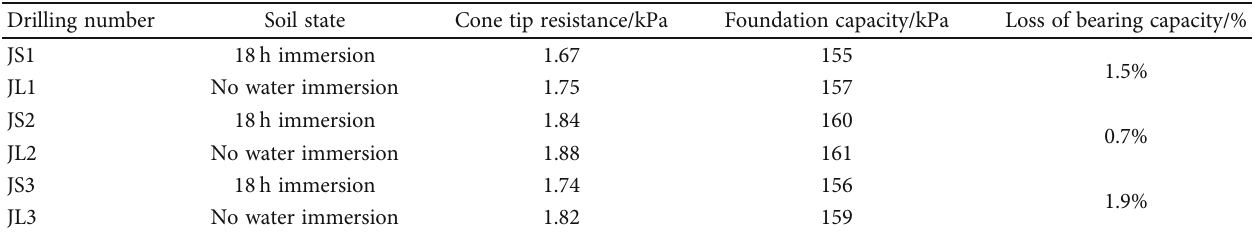
Table 5: Static cone penetration test data before and after immersion and back calculation of bearing capacity. Drilling number